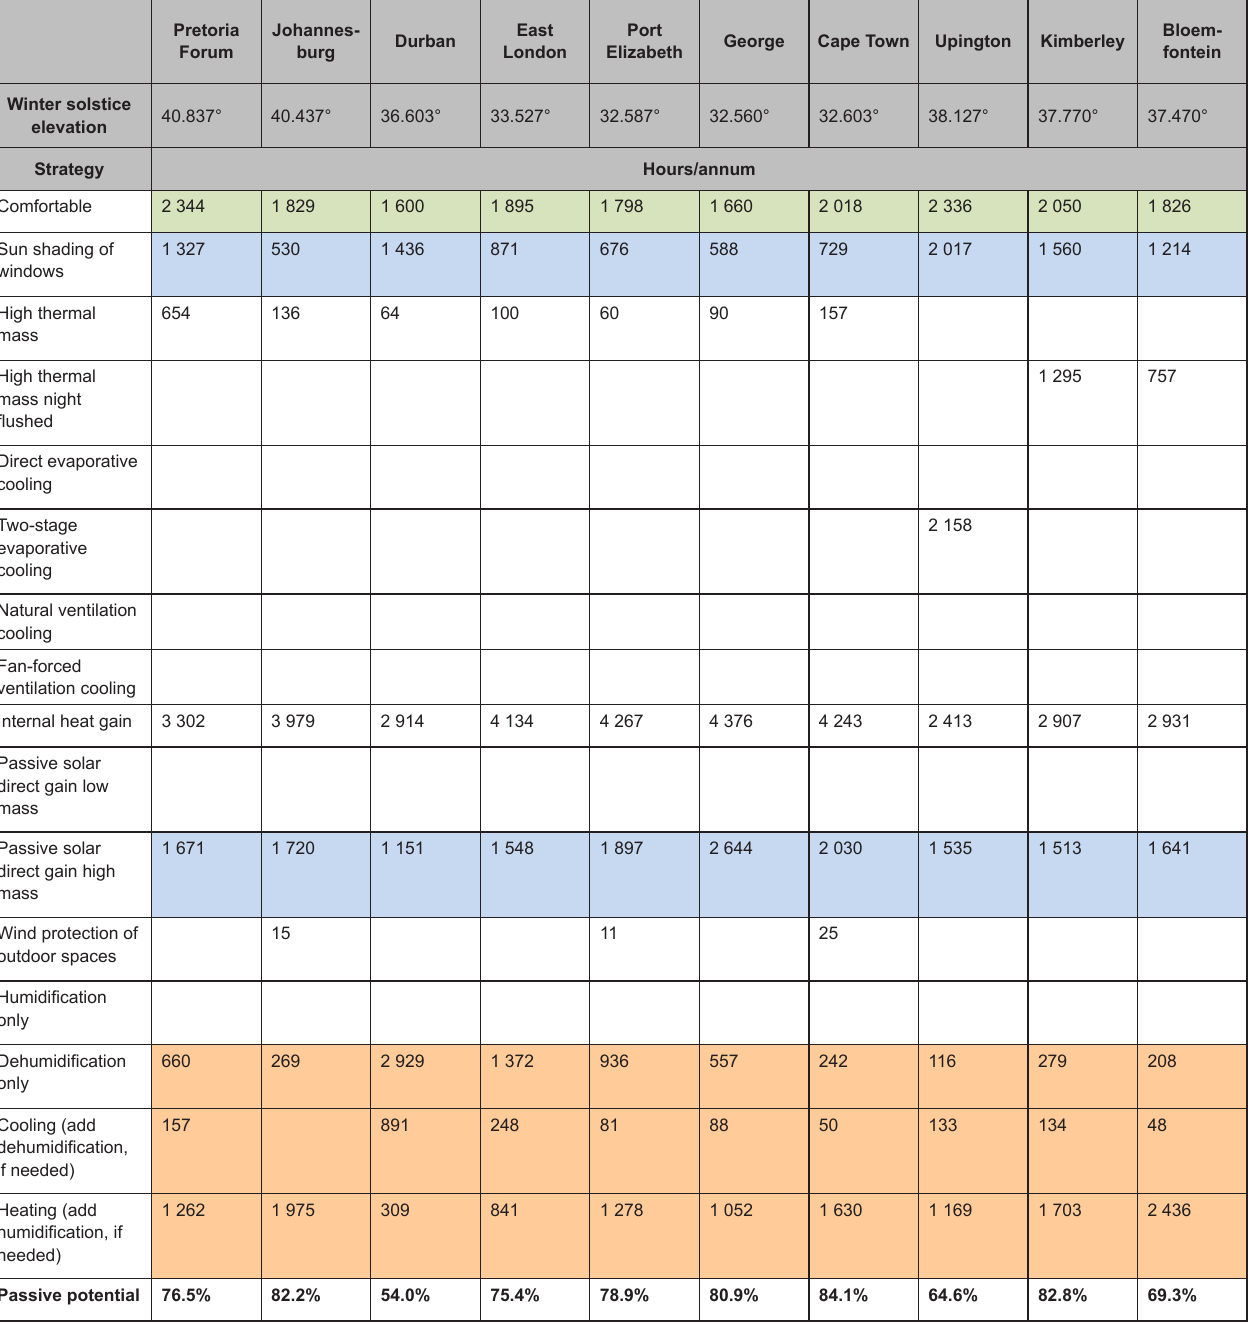
towns and cities. The figures were calculated. It is recommended that calculated by means of a bioclimatic these angles be used as a method analysis with Climate Consultant to ensure that buildings get enough 6.0 , using weather files generated solar insolation and have enough by means of Meteonorm v7.2.1 . natural daylight and adequate Table 8 should be read in conjunction natural ventilation. The measures with Figure 1. The blue bars in indicated in orange are not strictly Table 8 show the number of hours speaking passive. The theoretical that appropriate solar design would achievable passive potential is Table 8 is a detailed bioclimatic have an effect for ten South African indicated in the bottom row, if the analysis of the best set of passive cities. The winter solstice angles for design strategies for South African the various cities have also been measures in orange are not Table 8: Quantified best set of bioclimatic design strategies for South African towns and cities Pretoria Johannes- East Port Durban George Cape Town Upington Kimberley Forum burg London Elizabeth